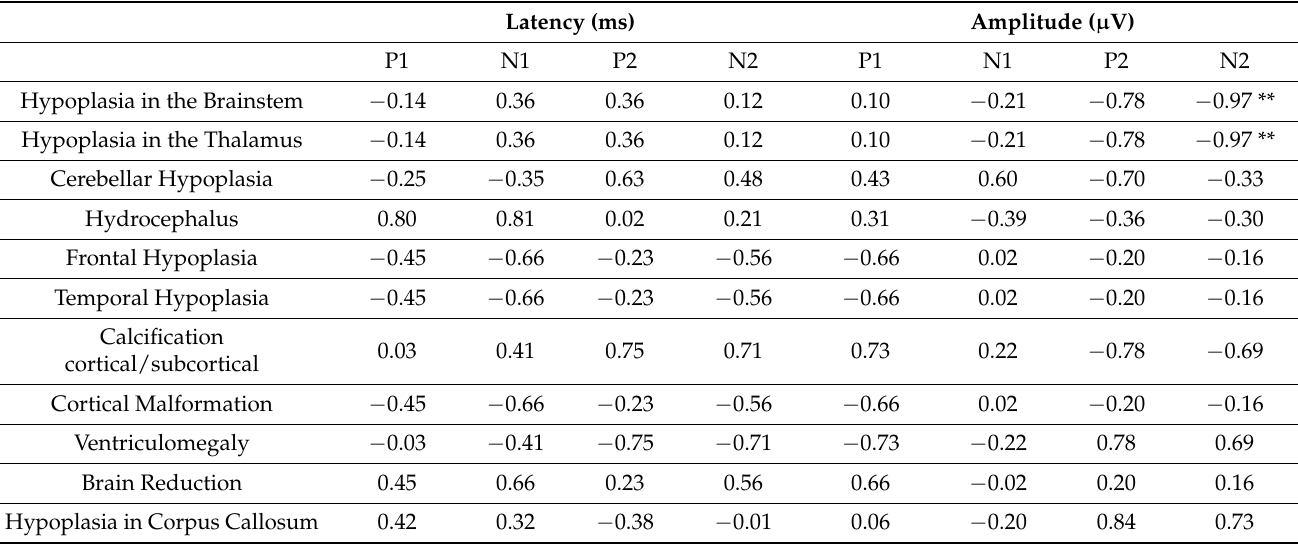
Table 3. Results of the point-biserial correlation coefficient between measurements of the CAEP and the findings of the MRI results in the children with